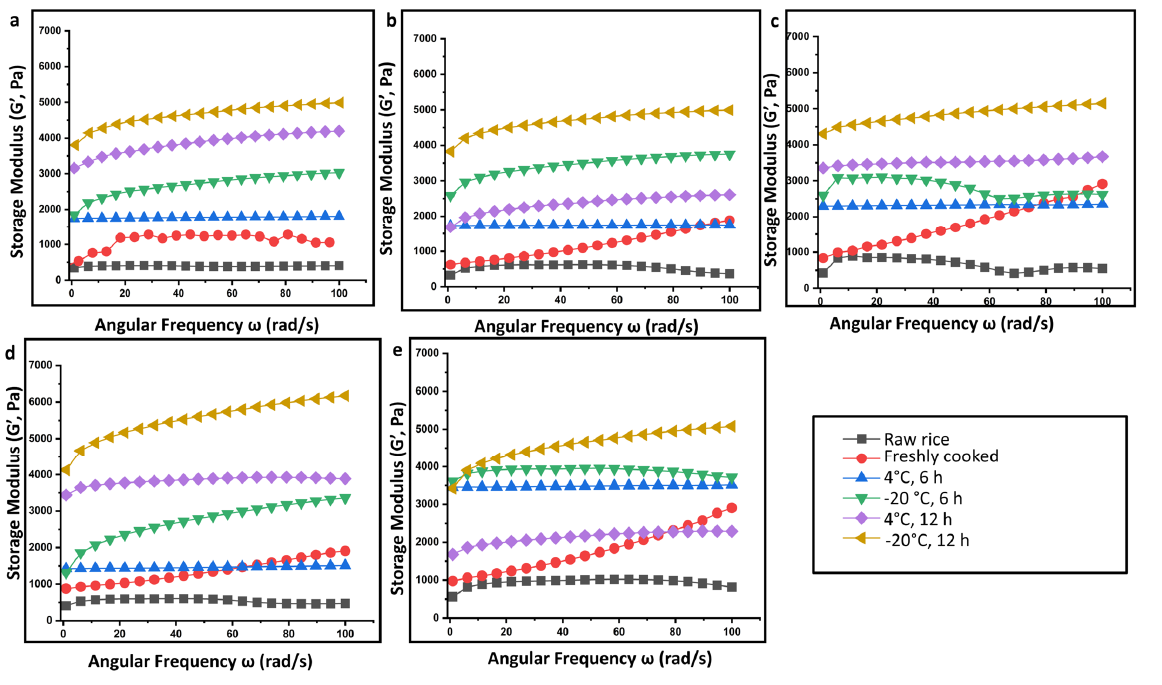
Figure 6. Storage modulus (G’) as a function of the angular frequency of rice samples subjected to different storage conditions for retrogradation: ( a ) Diasang lahi, ( b ) Khaju lahi, ( c ) Dhusuri bao, ( d ) Omkar, and ( e ) Bili rajamudi.